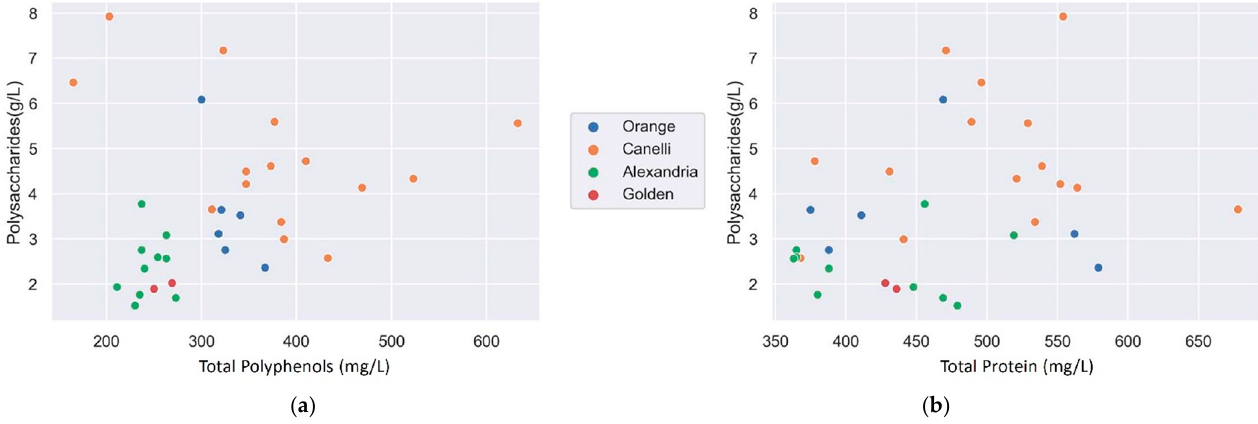
Figure 4. Ethanol-insoluble polysaccharides with total polyphenols ( a ) and total proteins ( b ) grouped by grape cultivar.